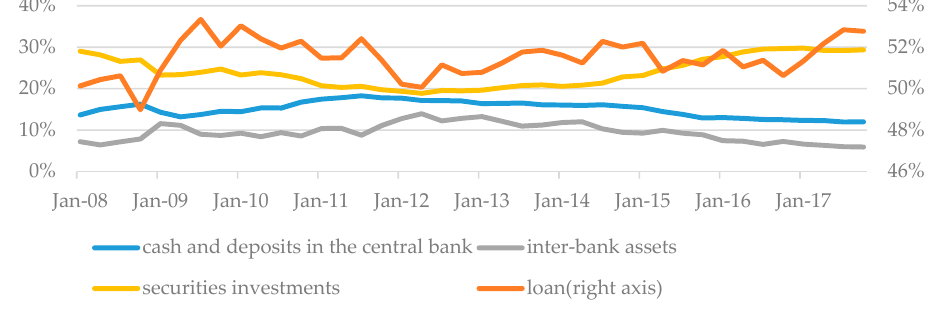
Figure 1. The trend of assets of commercial banks. (Data sources: Wind).